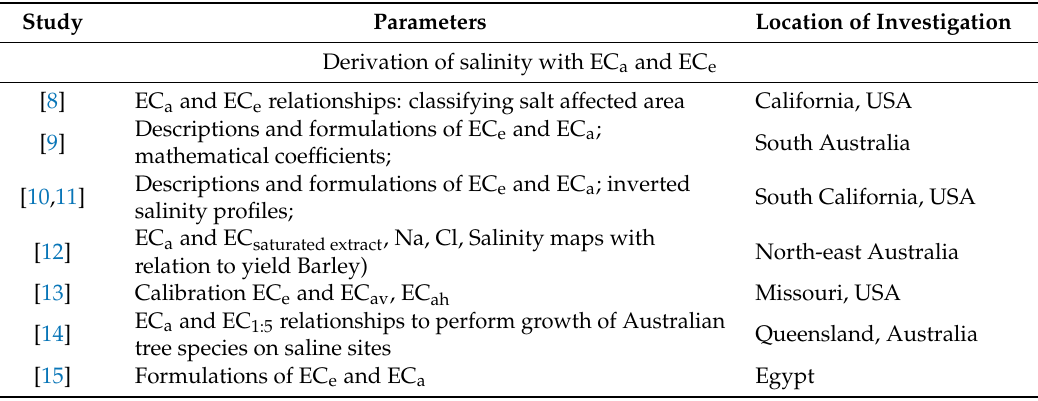
Table 1. Overview with literature of relationships between EM38-EC a and salinity.